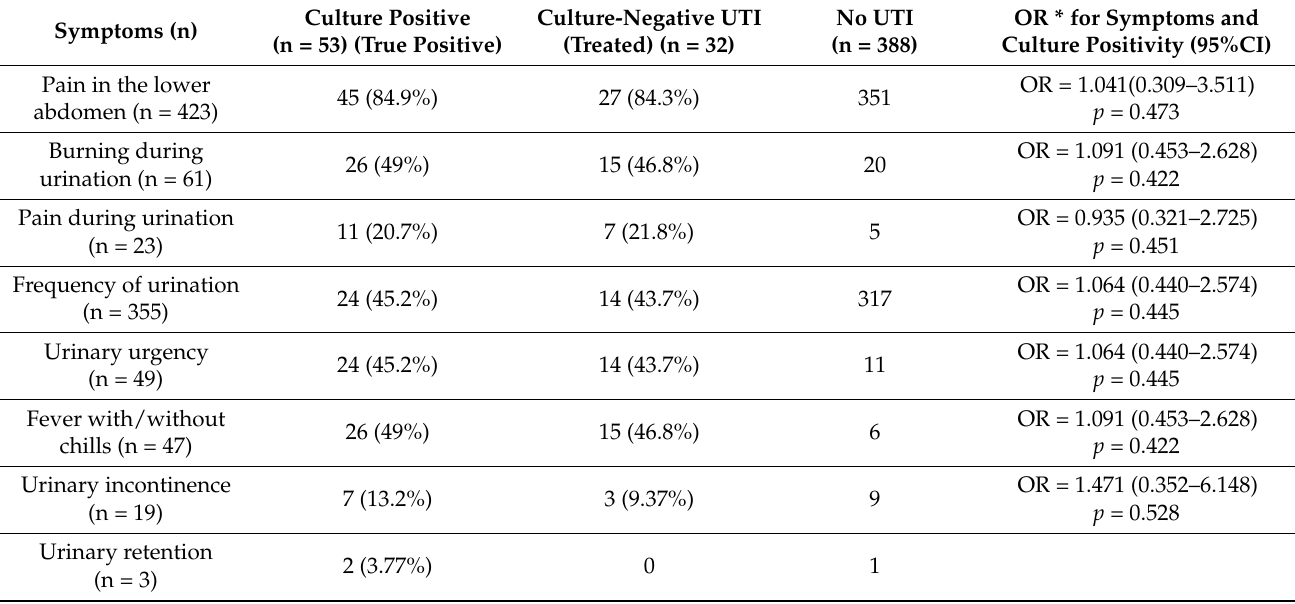
Table 2. Symptoms and correlation with Culture positive UTI (n = 473).